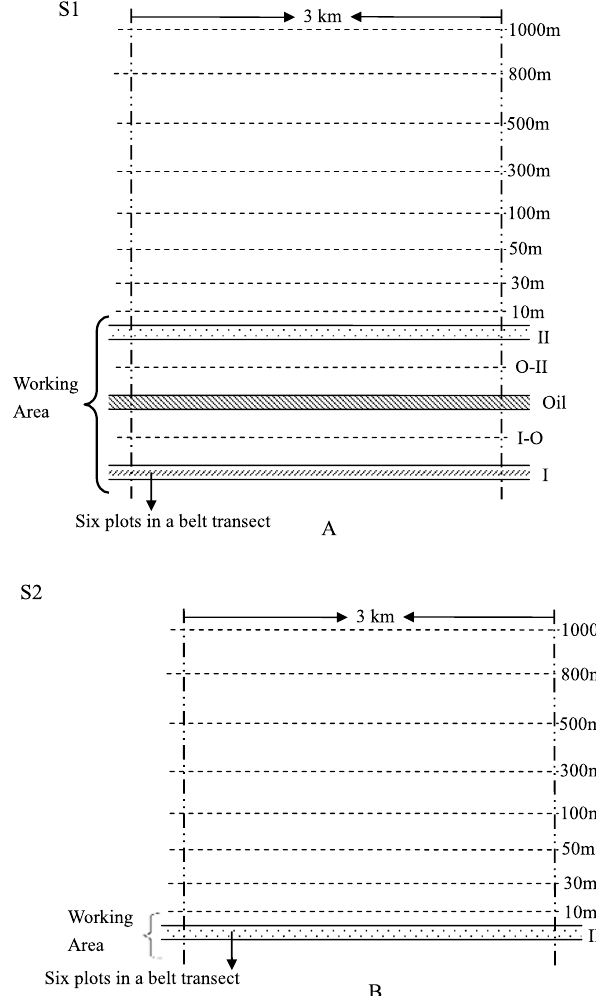
Figure 10. Design of the belt transects in S1 and S2. I, Oil, and II represent the belt transects set in the pipeline area of WEGP I, WCOP, and WEGP II, respectively; I-O and O-II are the belt transects between WEGP I and WCOP, and WCOP and WEGP II, respectively. 10-m, 30-m, 50-m, 100-m, 300-m, 500-m, 800-m, 1000-m belt transects were set on the north of pipeline area because there was a railway about 2 km to the south of the pipeline area in the S1 and a national road in the S2. The north part of the pipeline area was not affected by other construction and was natural environment before pipeline construction.